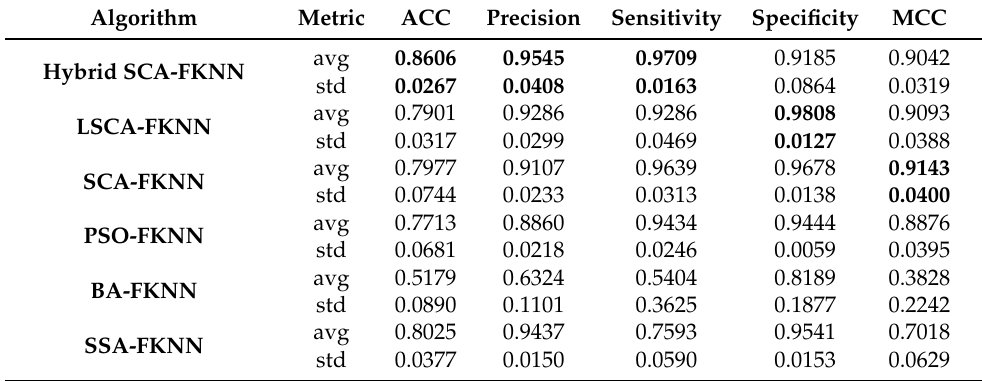
Table 11. Results of the hybrid-FKNN and comparison models on the user modeling dataset hamdi tolga dataset. (Bold indicates the best in comparison